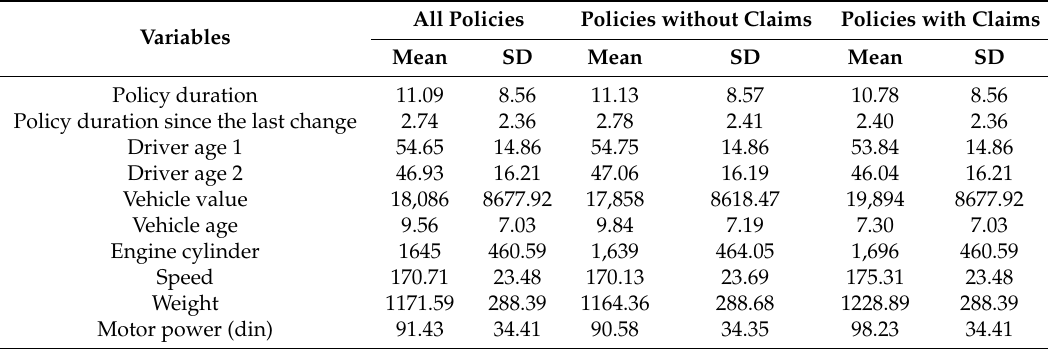
Table 2. The mean and standard deviation of numerical variables in the training set.